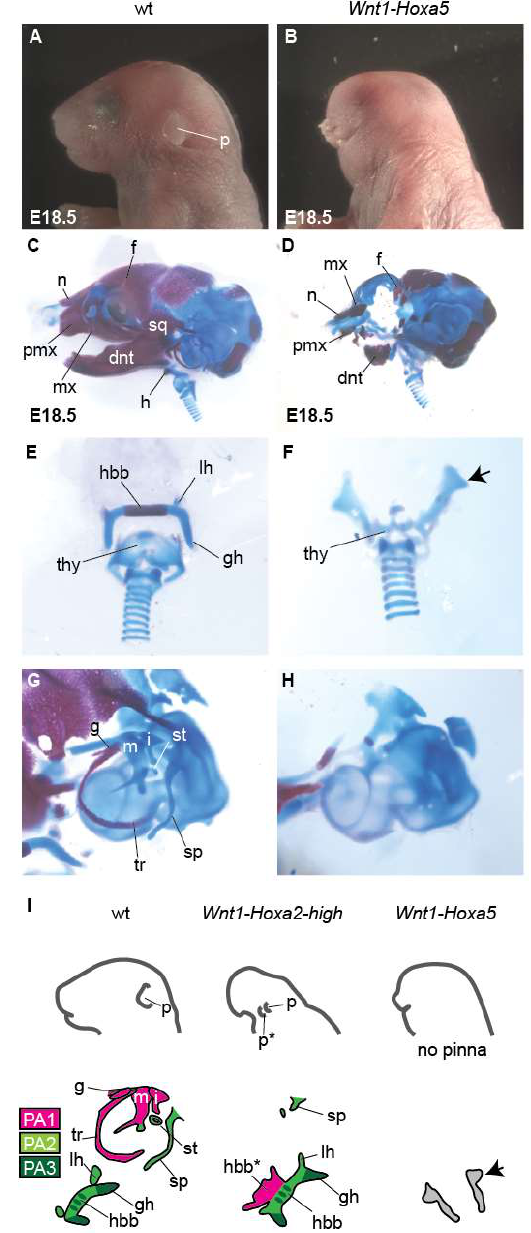
Figure 3. Craniofacial phenotype of Wnt1-Hoxa5 mouse fetuses. E18.5 wild-type (wt, A, C, E, G ) and Wnt1-Hoxa5 ( B , D , F , H ) fetuses were compared. ( A , B ) Lateral views of external appearance. The pinna (p) is absent in Wnt1-Hoxa5 fetuses. ( C , D ) Lateral views of skeletal staining. In ( D ), Wnt1- Hoxa5 hypoplastic phenotype is less severe than in Wnt1-Hoxa2-high fetuses (Figure 2I). ( E , F ) Higher magnification of the hyoid region. In ( F ), hyoid elements are absent and thyroid cartilage (thy) is reduced; (arrow) ectopic cartilage. ( G , H ) Higher magnification of middle ear structures. In ( H ), middle ear structures are absent. ( I ) Schematic representations of pinna (upper row) and middle ear and hyoid (lower row) phenotypes in Wnt1-Hoxa2-high (see also Figure 2) and Wnt1-Hoxa5 fetuses; (arrow), ectopic cartilage in hyoid region: note that it is difficult to assign its regional origin. dnt, dentary; f, frontal; g, gonial; gh, greater horn of hyoid bone; h, hyoid bone; hbb, body of hyoid bone; i, incus; lh, lesser horn of hyoid bone; m, malleus; mx, maxillary; n, nasal; p, pinna; pmx, premaxillary; sp, styloid process; sq, squamosal; st, stapes; thy, thyroid; tr, tympanic ring; *, duplicated